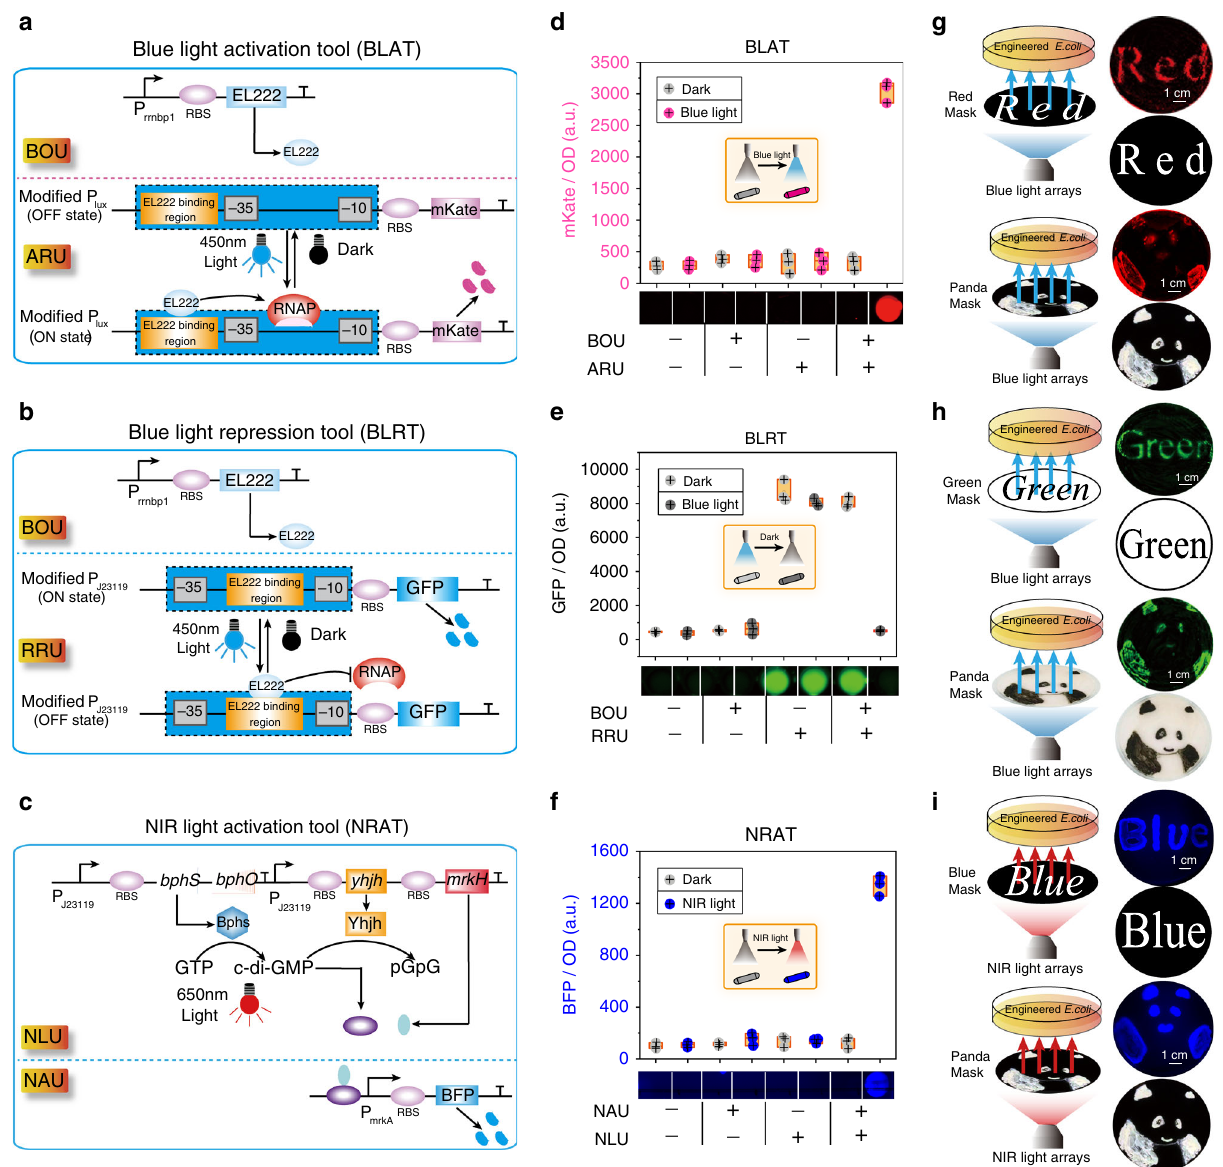
Fig. 4 The performance of three basic optogenetics tools. a – c The schematic diagram of BLAT (blue-light), BLRT (blue-light), and NRAT (NIR-light), respectively. Panels a and b are adapted from Jayaraman et al. 38 . d – f Fluorescence activation with BLAT, BLRT, and NRAT under dark, 0.8 W/cm 2 blue- light, and NIR-light, respectively. g – i Blue-light or NIR-light LEDs were mounted on the bottom of a photomask with a setup for pattern illumination. Red, green, blue, and chinese panda-patterned masks made from aluminum foil were placed on top of the photomask to illuminate culture plate. In this setup, photomasks were placed onto the bottom of the engineered E. coli -culture plate with BLAT, BLRT, and NRAT, respectively. P J23119 : constitutive promoter; P P Erythrobacter litoralis ; bphS : a c-di-GMP diguanylate lux : quorum sensing promoter; mrkA : MrkH-targeted promoter; EL222: light-sensitive protein from cyclase from Rhodobacter sphaeroides ; bphO : a heme oxygenase from Rhodobacter sphaeroides ; yhjH : c-di-GMP PDE from E. coli ; mrkH : a transcriptional factor from Klebsiella pneumoniae . The box plots de fi ne the minima, maxima, center, and bounds of box. d – f n values are shown as mean ± s.d. from three ( n = 3) biological independent replicates. Source data underlying Fig. 4d – i are provided as a Source data fi